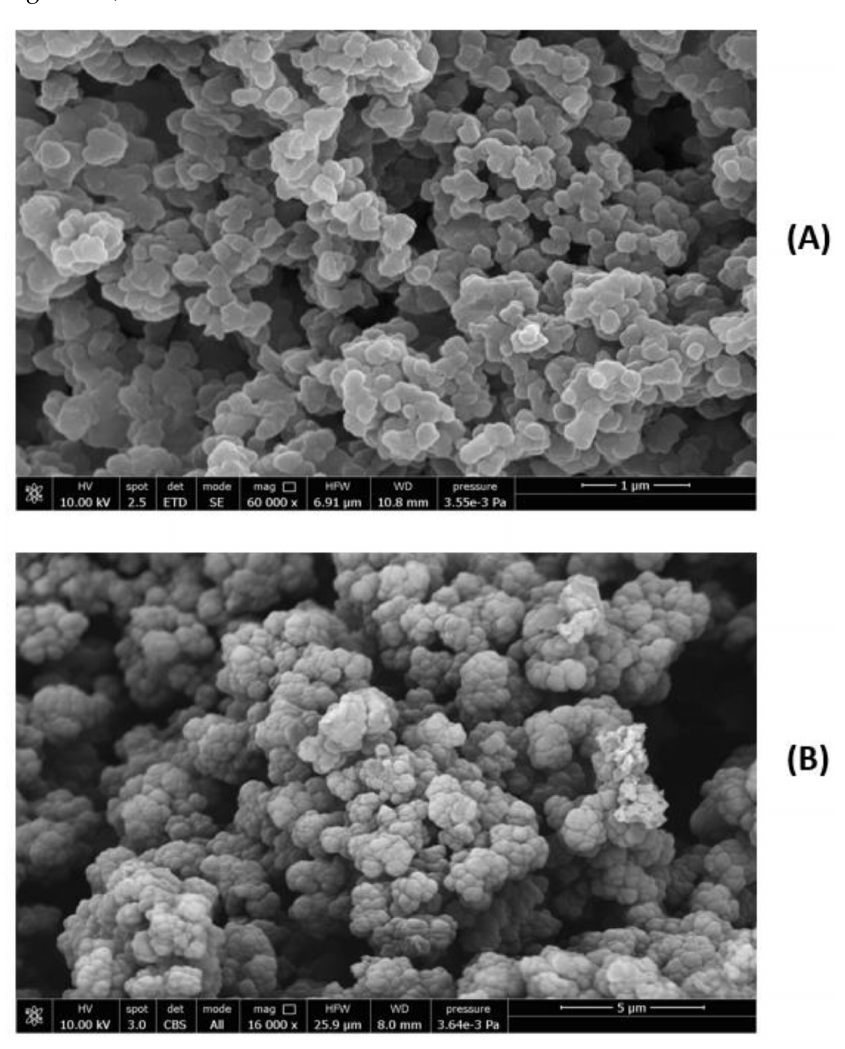
Figure 6. SEM images of ( A ) CPs and ( B ) MIPs. The tendentially spherical NPs appear agglomerated, but it was possible through the ImageJ software to single out the particles, showing sub-micrometric dimensions. The CP average diameter was 291 ± 70 nm, and the MIP average diameter was 344 ± 33 nm. The size of the single particles shows an average value slightly higher for MIPs after extraction relative to CPs, indicating a modest influence of the template on the MIP dimension. MIPs and CPs after dispersion in EtOH and sonication were also analyzed by DLS. In EtOH, the MMP9 molecules tend to aggregate, giving a value of 204 ± 40 nm, and the size of the MIPs before the extraction is about 988 ± 100 nm. After the extraction, the Z-average value of MIPs is around 750 ± 100 nm, and a value of 700 ± 60 was obtained for CPs. These results indicate that the enzyme was efficiently removed from the MIPs, since the value obtained after the template extraction is smaller than that before extraction, confirming the hypothesis that the formed surface cavities by imprinting do not limit the template removal. Furthermore, considering the DLS values obtained for MIPs (after the extraction) and CPs, we can speculate that the residual immobilized enzyme after the MIP